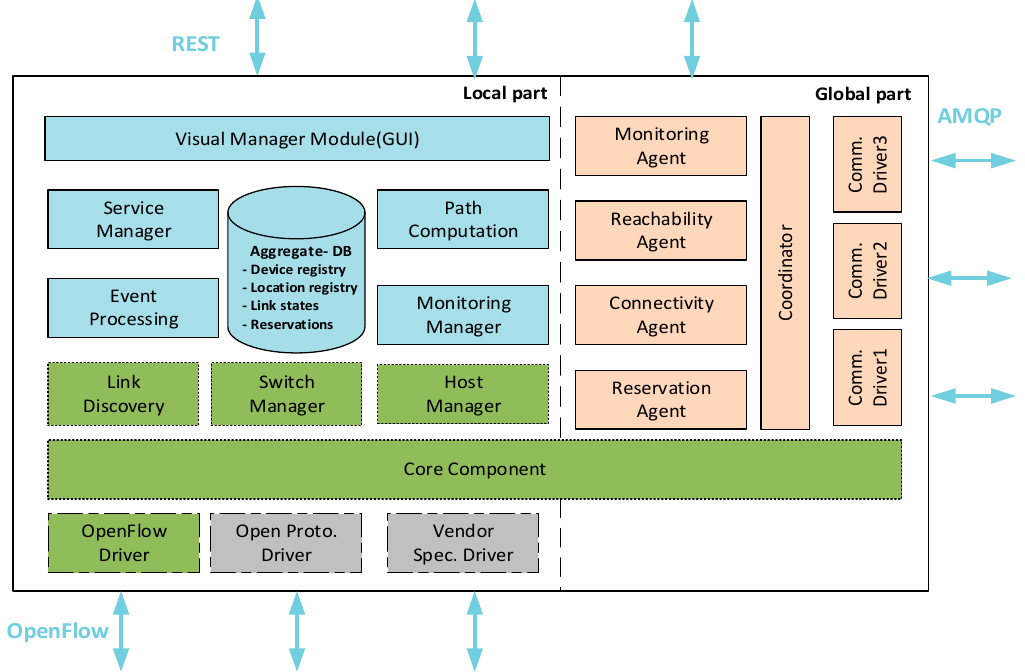
Figure 2. FD-SDWMN controller architecture. AMQP: Advanced Message Queuing Protocol.